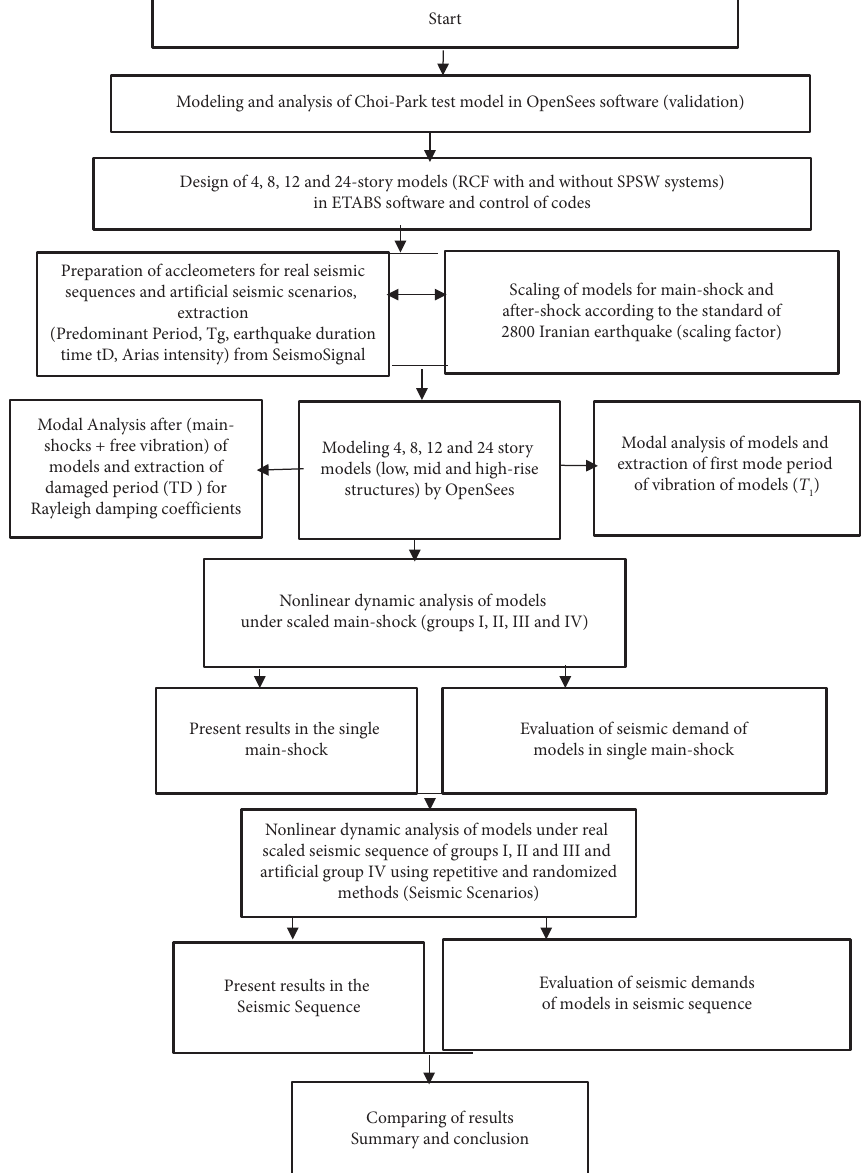
Figure 1: Flowchart of